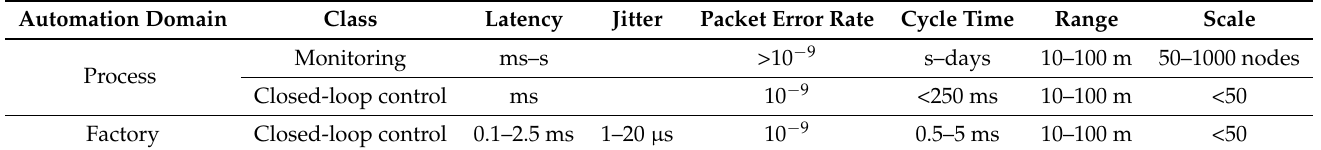
Table 1. Example requirements for communication in the industrial automation domain